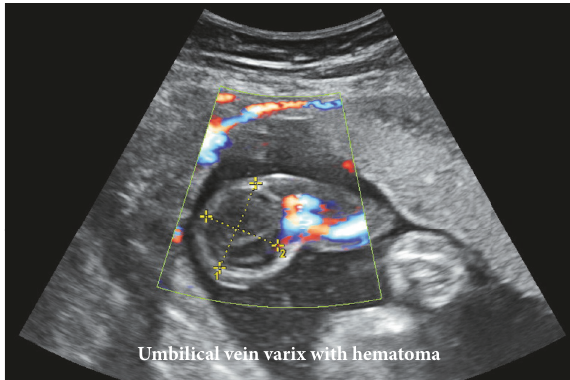
Figure 2: Ultrasonogram at 28 weeks of gestation shows enlarge- ment of the thrombus or hematoma (measured 29 × 24 mm) beside the umbilical vein varix (UVV).